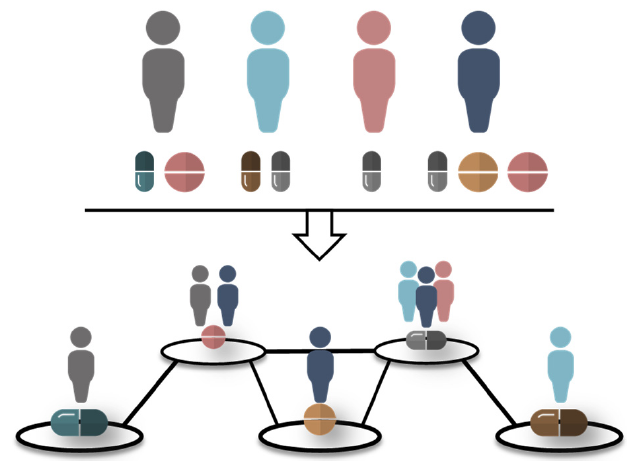
Figure 1. Representation of a drug prescription network. Data on drug (co)prescriptions were analysed to create drug prescription networks that correspond to the five levels of the Anatomical Therapeutic Chemical (ATC) classification system. Nodes and edges in these networks were the single ATCs and ATC–ATC pairs found in the original dataset, respectively.